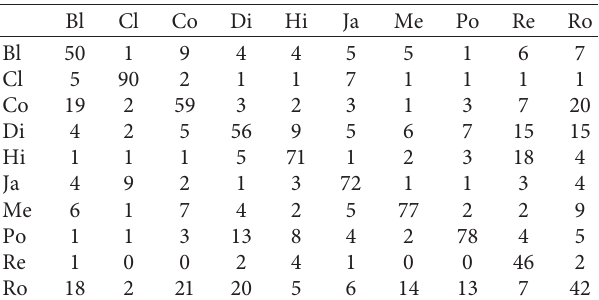
Table 2: Confusion matrix of GTZAN dataset (using timbre characteristics).